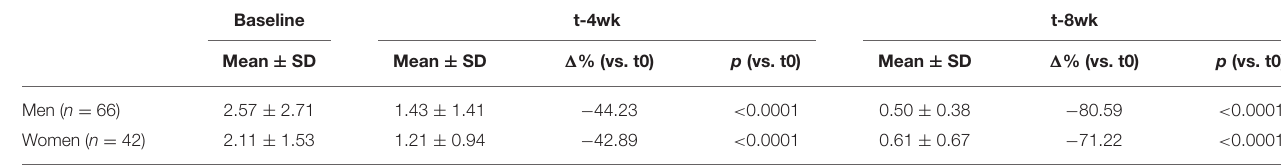
TABLE 2 | Serum levels of TMAO before and after 4-week and 8-week treatment with Taurisolo ® in study participants stratified for gender. Baseline